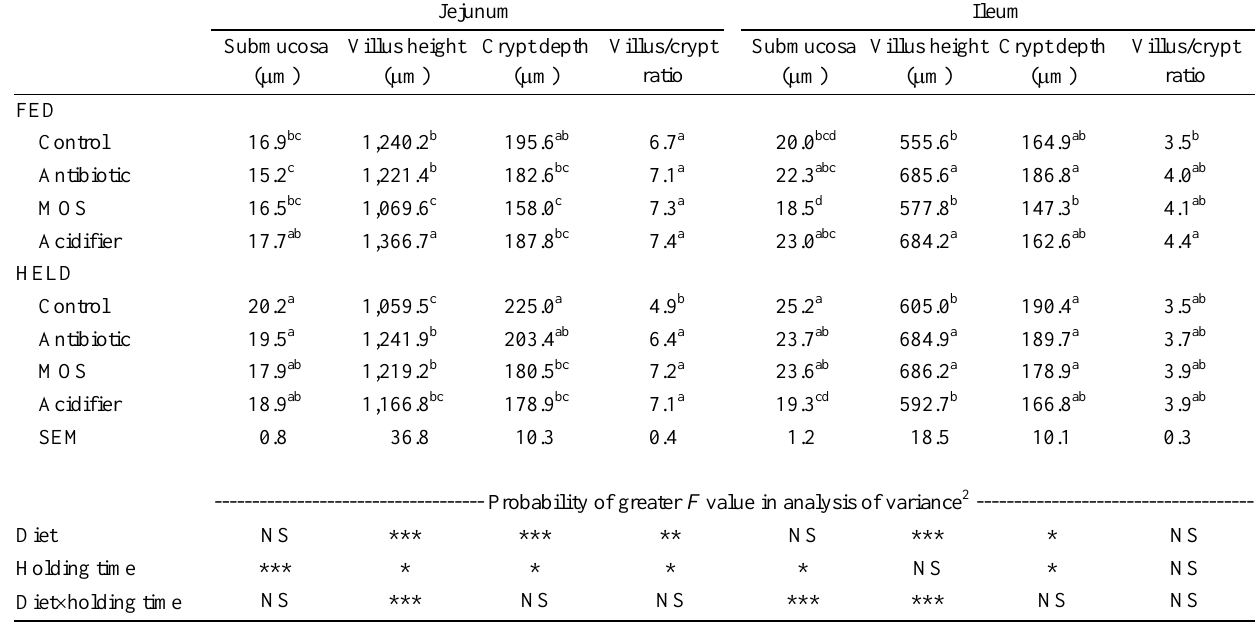
Table 6. Effects of post hatch holding time and dietary supplements on the morphology of small intestine at d 14 1